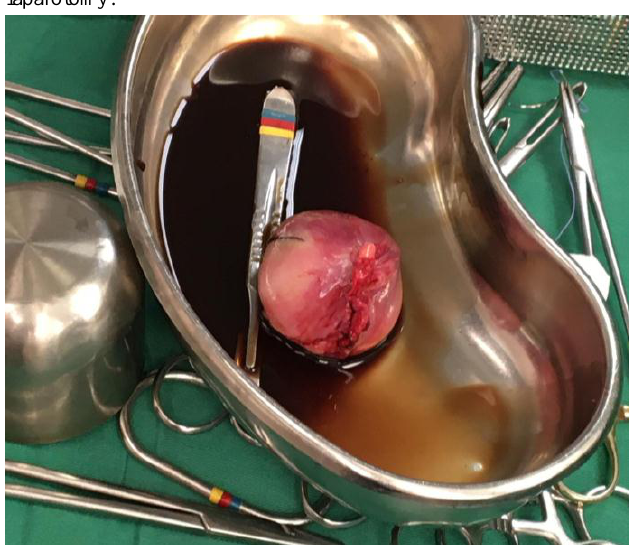
Figure 4 : excised rudimentary